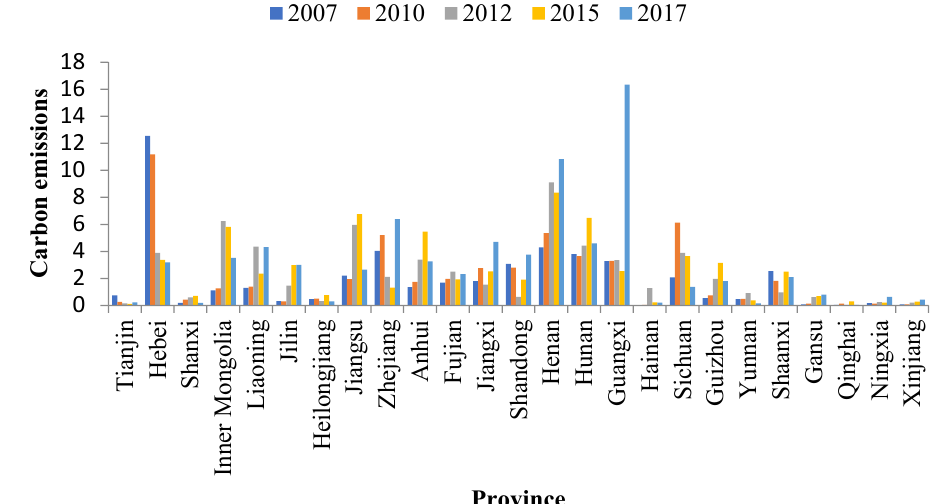
Figure 6. Change in carbon emissions in the building materials industry.